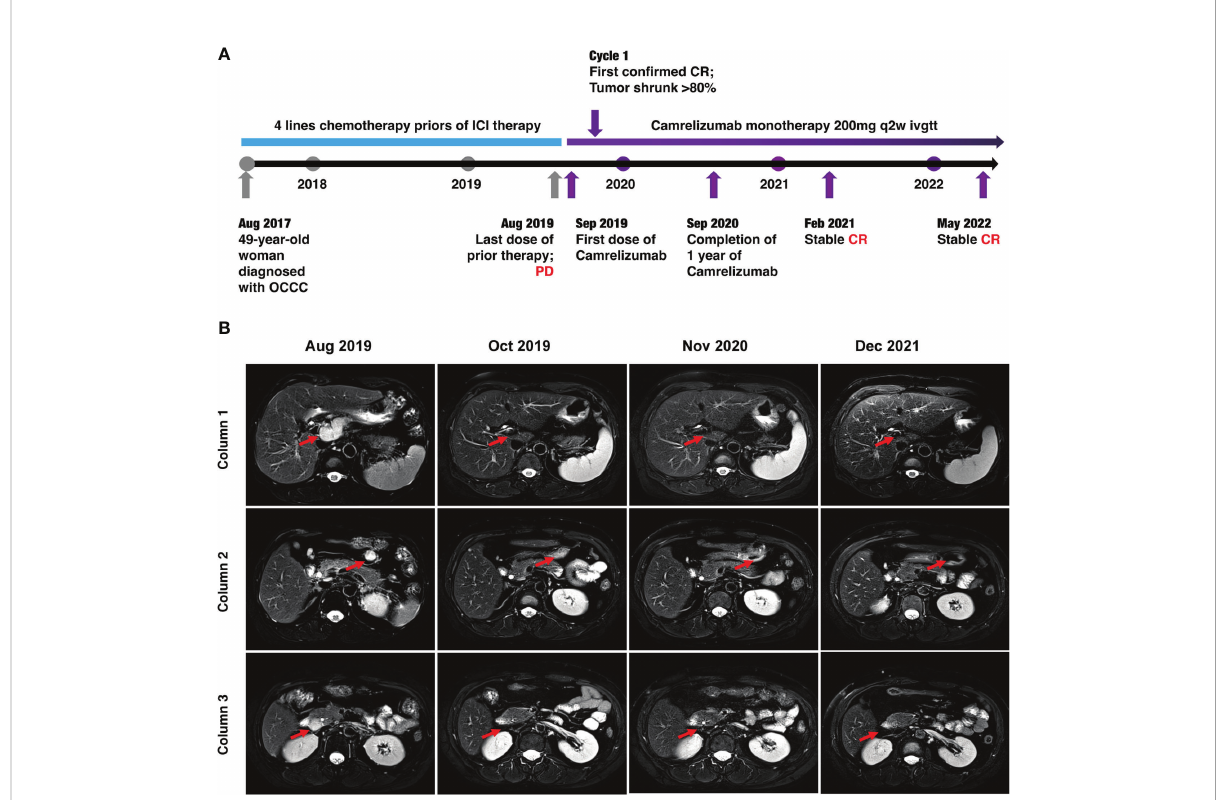
FIGURE 2 Timeline of the case and MRI fi ndings. (A) Timeline of patient diagnosis, prior therapies, and immunotherapy. (B) MRI scans demonstrating activity (i.e., complete response) to Camrelizumab. The lymph node metastases were located in front of the inferior vena cava (red arrows) in column 1, anterior to the tail of the pancreas (red arrows) in column 3, and around the head of the pancreas (red arrows) in column